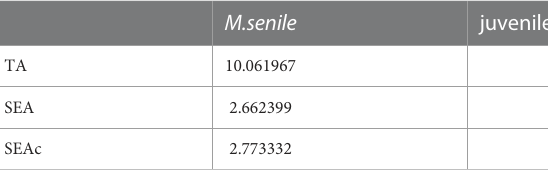
TABLE 2 Summary statistics of SIBER analysis for each